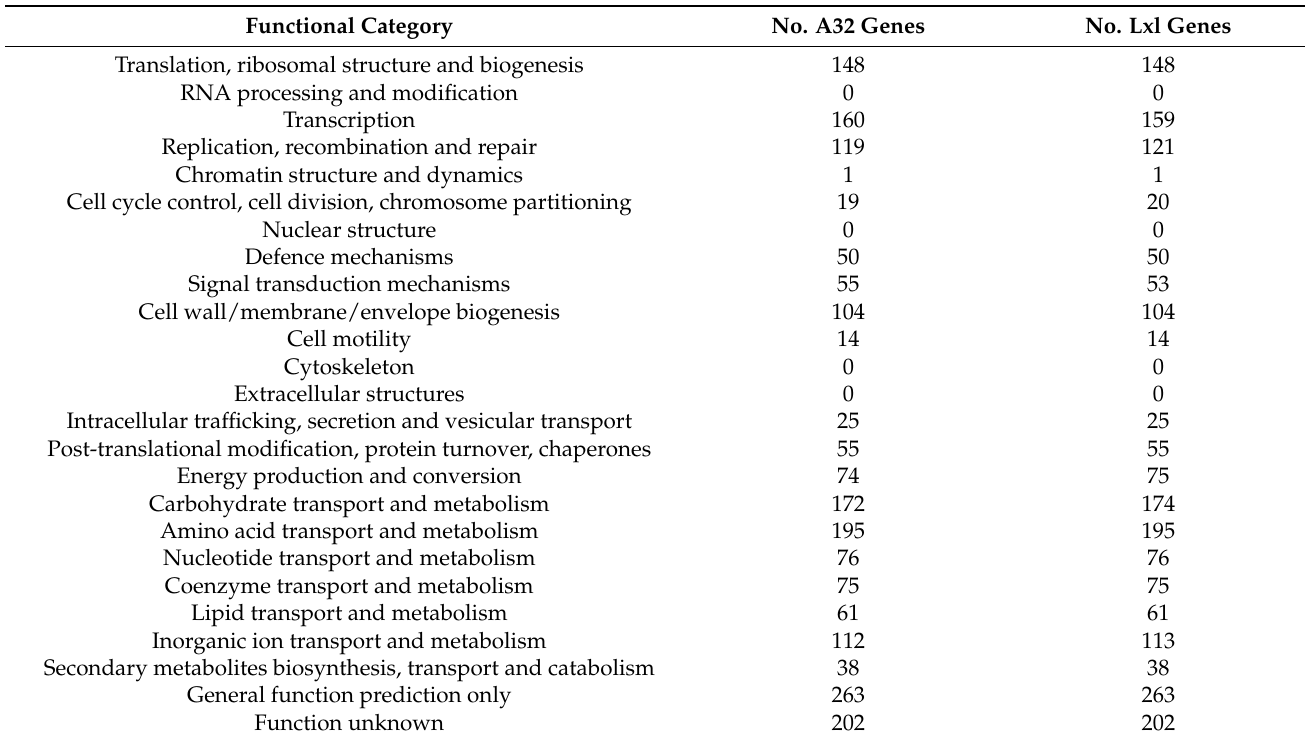
Table 2. GO functional